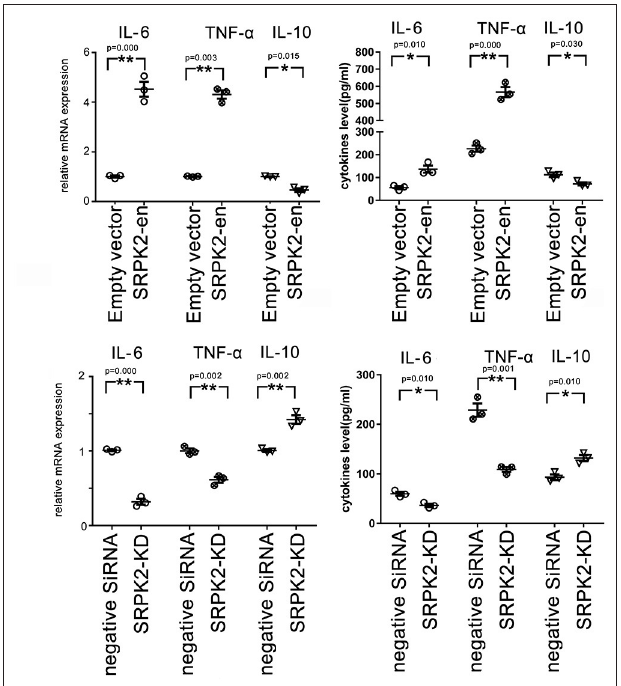
FIGURE 2 | The expression of SRPK2 induces changes in inflammatory cytokines (TNF- α and IL-10) at mRNA and protein levels in the BV2 cells. The expression of SRPK2 was enhanced by the transfection of recombinant lentiviral vectors (SRPK2-en) or knockdown by the transfection of siRNA (SRPK2-KD) in the BV2 cells. The cells and culture medium were collected, respectively. Total RNA was extracted from cells and the mRNA levels of the cytokines of the cells were examined by real-time qPCR. The cytokine levels in the culture medium were examined by ELISA. Our data showed that the cells transfected with SRPK2 recombinant lentiviral vectors had higher expression and secretion levels of IL-6 and TNF- α , but lower levels of IL-10 at mRNA and protein levels compared to the cells transfected with empty vectors. The BV2 cells that were transfected with SRPK2 siRNA had lower expression and secretion levels of IL-6 and TNF- α , but higher levels of IL-10 at mRNA and protein levels compared to the cells that were transfected with negative siRNA. All the results were representative of three independent experiments performed in triplicate. The data were presented as the mean ± SEM of the three replicates (* p < 0.05, ** p < 0.01 vs. the control by the Student’s t -test). SRPK2-en, transfection increased SRPK2 expression; SRPK2-KD, knockdown of SRPK2 by siRNA; TNF- α , tumor necrosis factor- α ; IL-10, interleukin-10; IL-6, interleukin-6; mRNA, messenger RNA; qPCR, quantitative PCR.